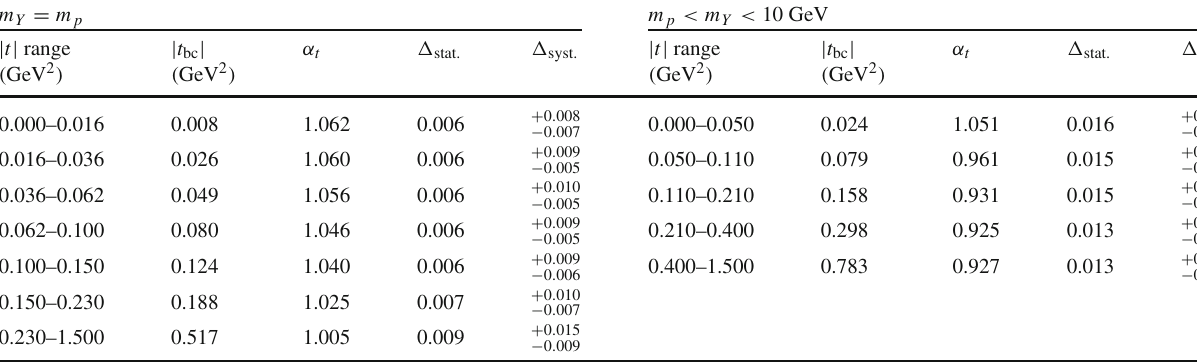
Table 16 Fit parameters α t for the fit of simple power-law functions to the energy dependencies of the elastic and proton-dissociative